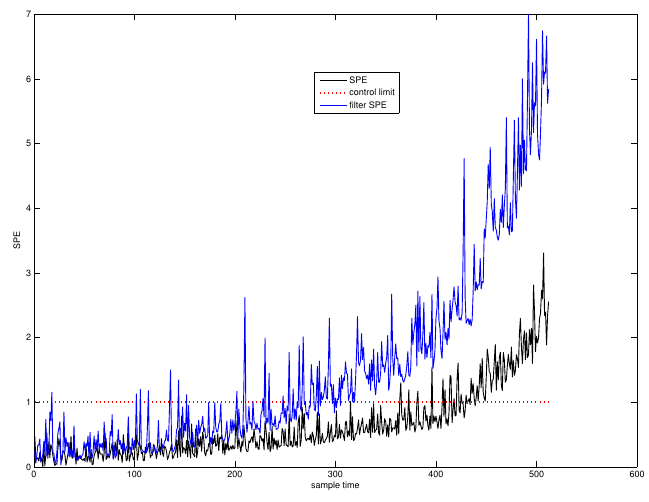
Figure 5. SPE chart for WF-PCA.